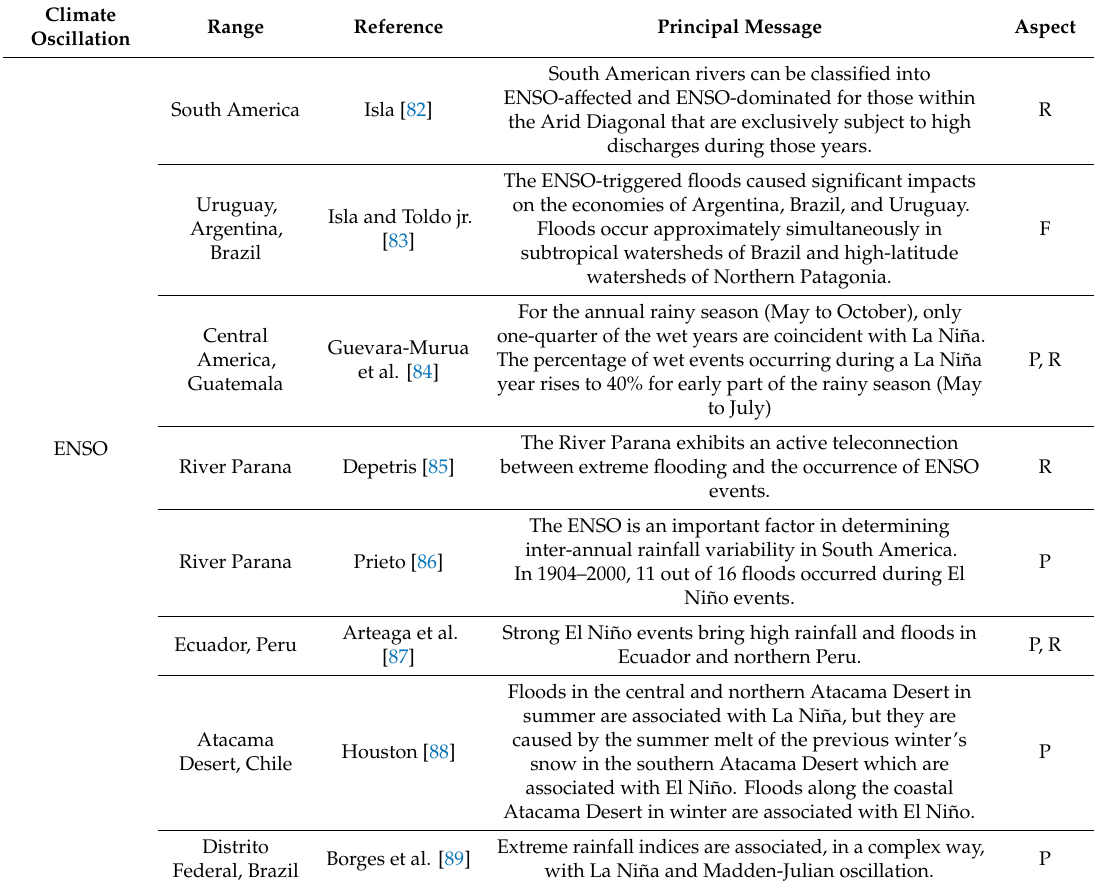
Table 5. Review of links between climate oscillation and floods for South America, as reported in the literature. Aspects of reference in the rightmost column—as in Table 2.